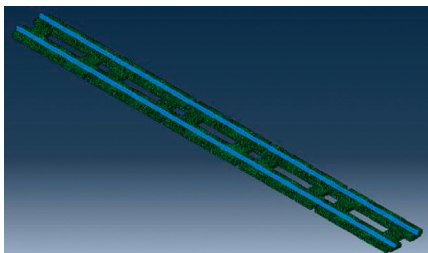
Figure 7: Finite element model for modal analysis of the track plate